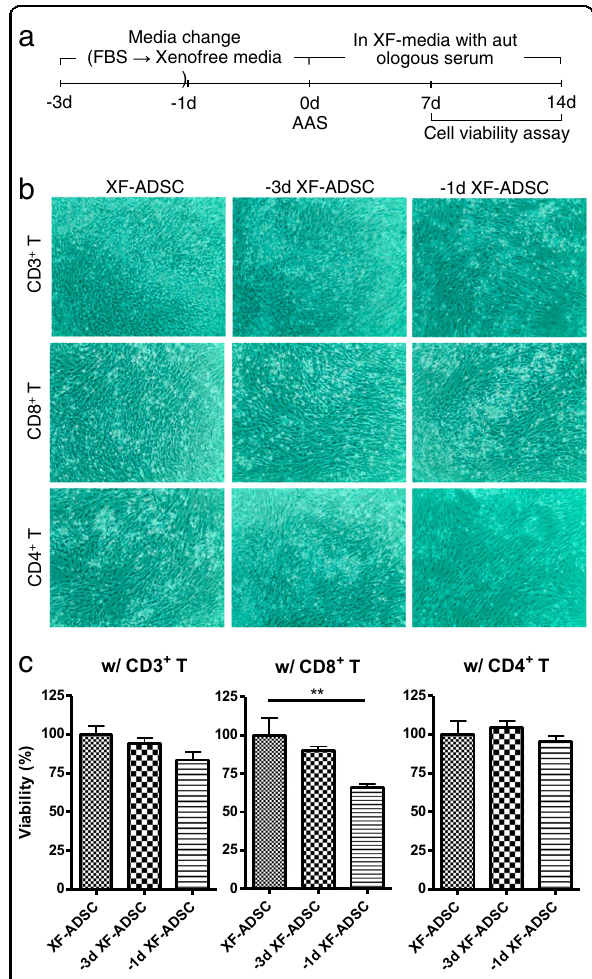
Fig. 1 Adipose-derived mesenchymal stem cells (ADSCs) previously exposed to xenogeneic serum induce cytotoxicity in recipient CD8 T cells. Human ADSCs were subjected to allogeneic antigen stimulation for 7 days, and then ADSC viability was analyzed. a The 7- and 14-day experimental schemes. b For allogeneic antigen stimulation, T cells and T cell-depleted peripheral blood mononuclear cells (Td-PBMCs) were incubated for 7 days with allogeneic ADSCs in xeno-free medium (XF-ADSCs) containing 5% autologous serum. XF- ADSCs were cultured in xeno-free medium immediately after isolation, and − 3d XF-ADSCs or − 1d XF-ADSCs were changed from fetal bovine serum (FBS)-containing medium to xeno-free medium 3 days or 1 day before the experiment, respectively. XF-ADSCs were used as controls for − 3d XF-ADSCs and − 1d XF-ADSCs in the cell viability assay. Human CD4, CD8, and CD3 T cells were used as recipient T cells. c Graphical representation of ADSC viability corresponding to ( b ) ( n = 6 for each sample); ** p < 0.001. AAS allogeneic antigen